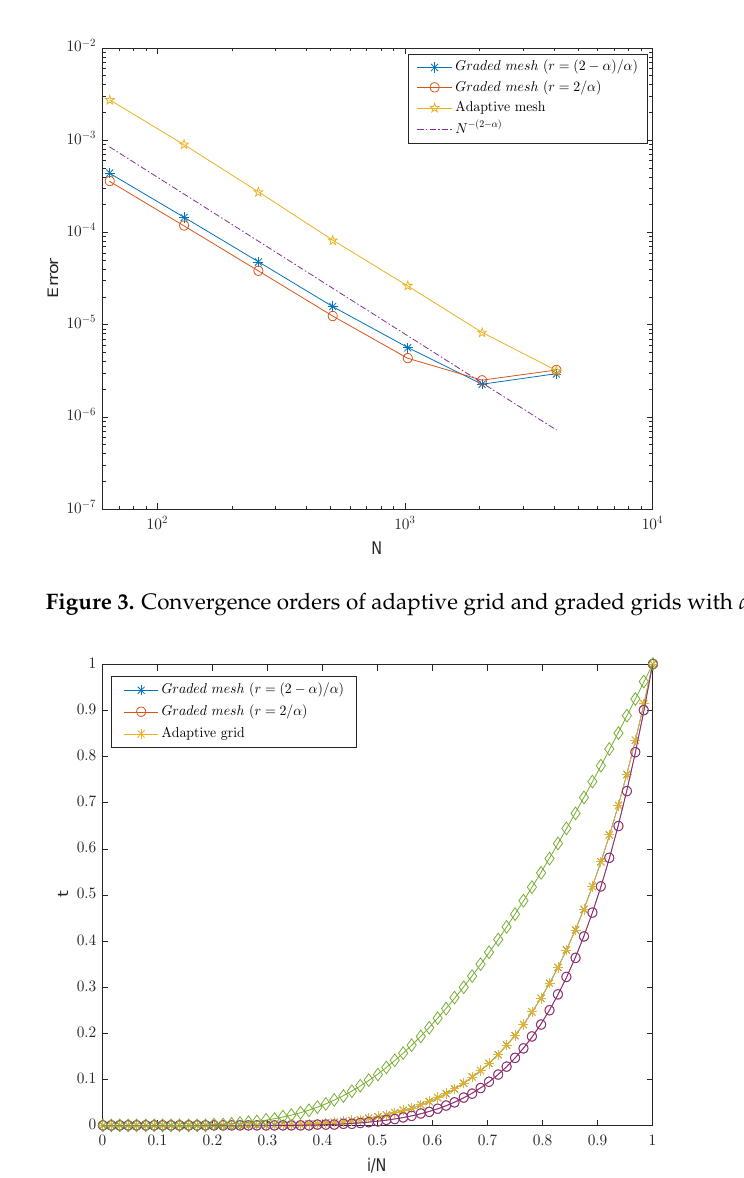
Figure 4. The comparison of our adaptive mesh and graded meshes with α = 0.3 and N =